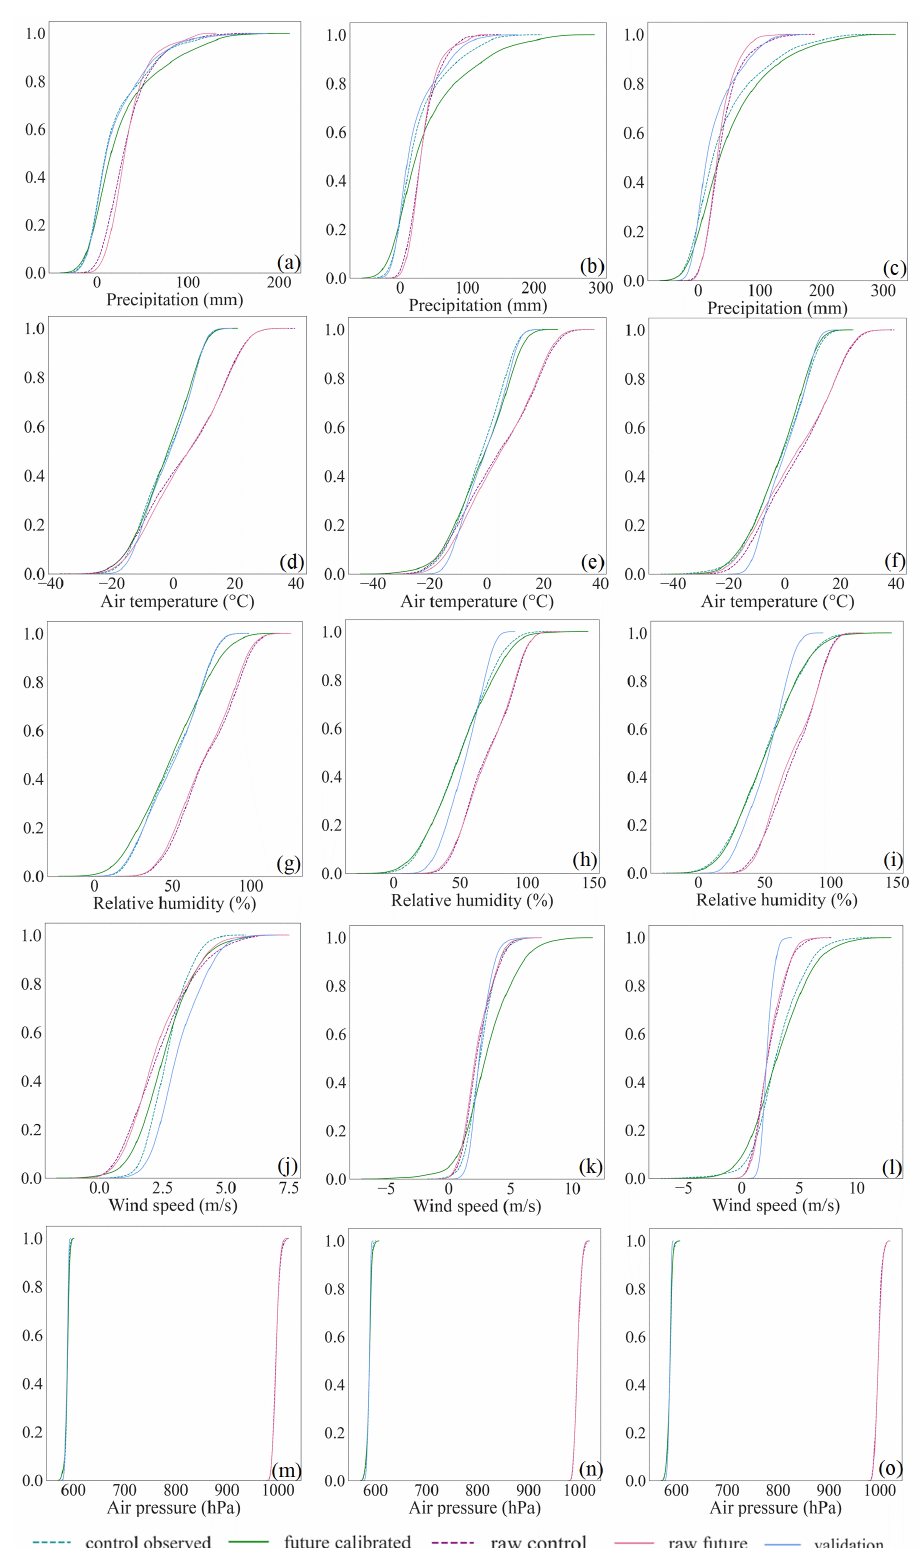
Figure 10. Changes in CDF of the five major variables during the successive adjustments at the Naqu site based on GCM MPI simulations. The abscissa is the value of the variable and the ordinate is the cumulative density. The left ( a , d , g , j , m ), middle ( b , e , h , k , n ) and right ( c , f , i , l , o ) columns represent the first (1970 – 1984), second (1985 – 1999) and third (2000 – 2014) adjustments, respectively. Rows from the upper down represent precipitation ( a – c ), air temperature ( d – f ), relative humidity ( g – i ), wind